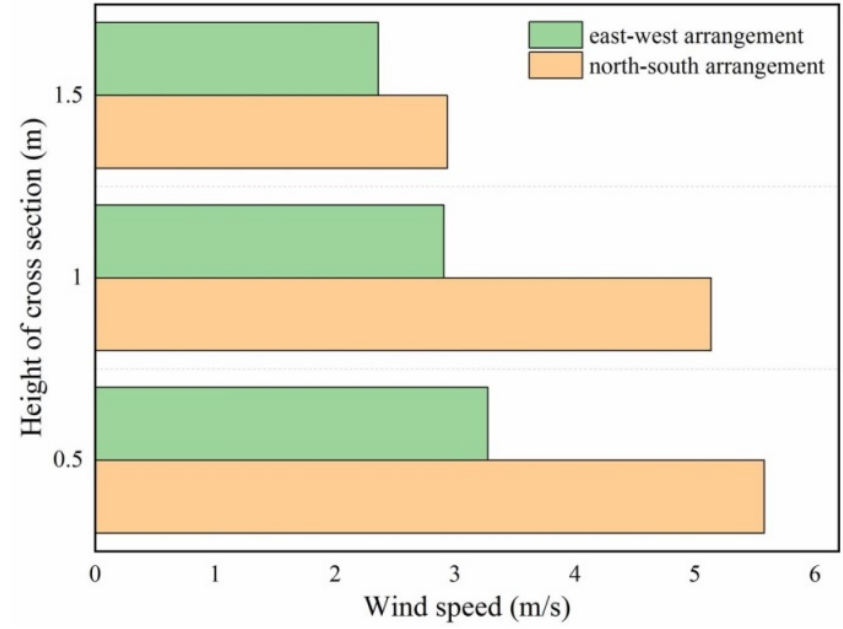
Figure 6. Velocity magnitudes of typical horizontal cross sections under different arrangements of cultivation racks.